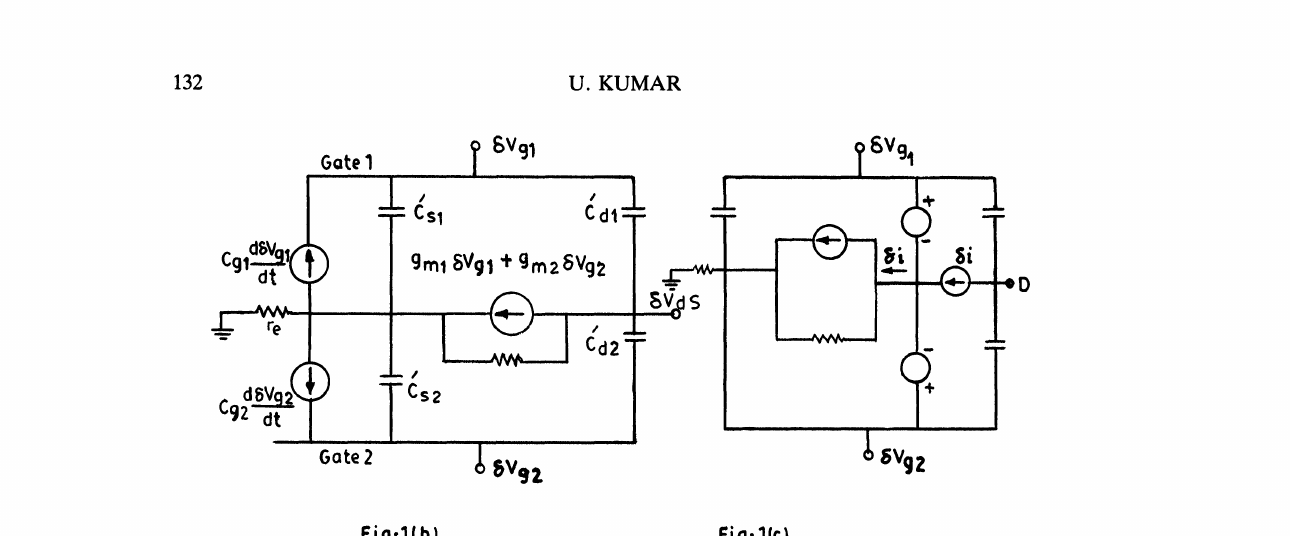
FIGURE lb Small-signal model for operation beyond pinch-off with several extrinsic elements added. The printed capacitances includes extrinsic components. The fig. shows one method for accounting for re, the extrinsic source resistance. FIGURE lc Form of model proposed by Hudson for a symmetrical abrupt junction FTFET operated beyond pinch-off and excited by small signals. The sources shown are dependent